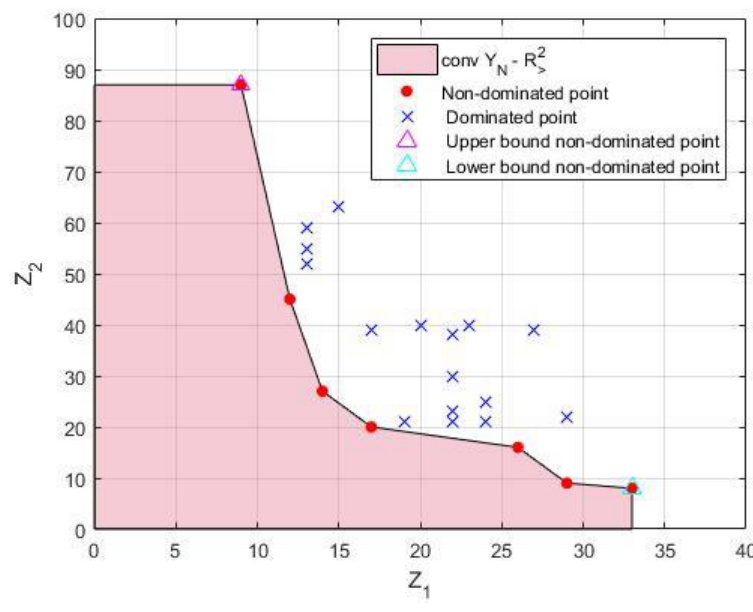
Figure 1. All potential non-dominated points Table 5. Potential non-dominated points for the first objective function 𝑍